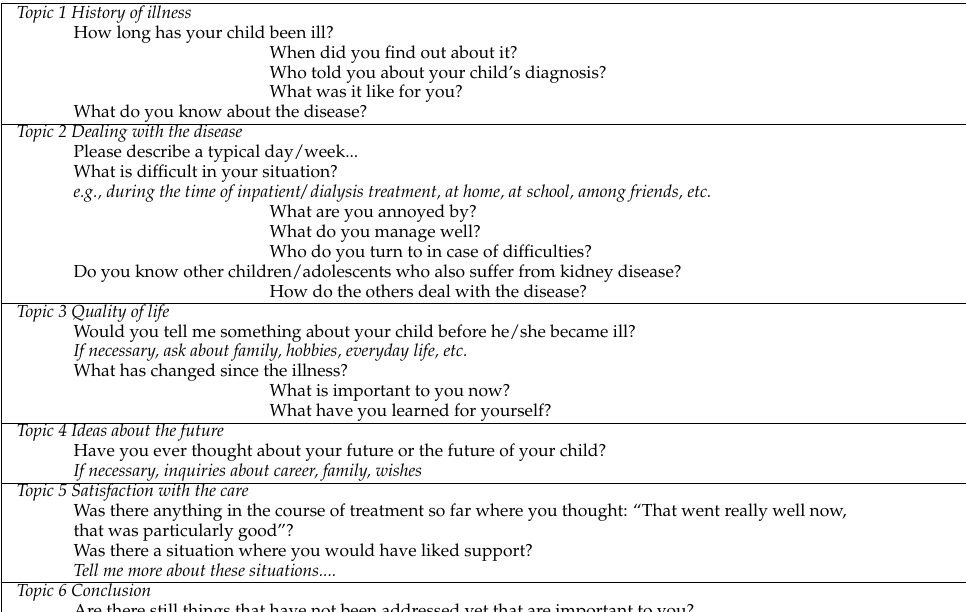
Table A1. Interview guide for parents.